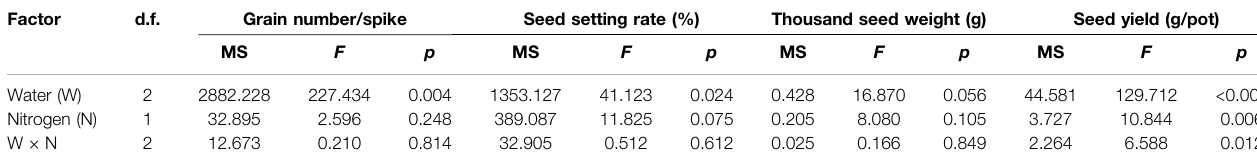
TABLE 1 | Results of two-way ANOVAs for the effects of water, nitrogen and their interactions on yield components of L. chinensis. Factor d.f.